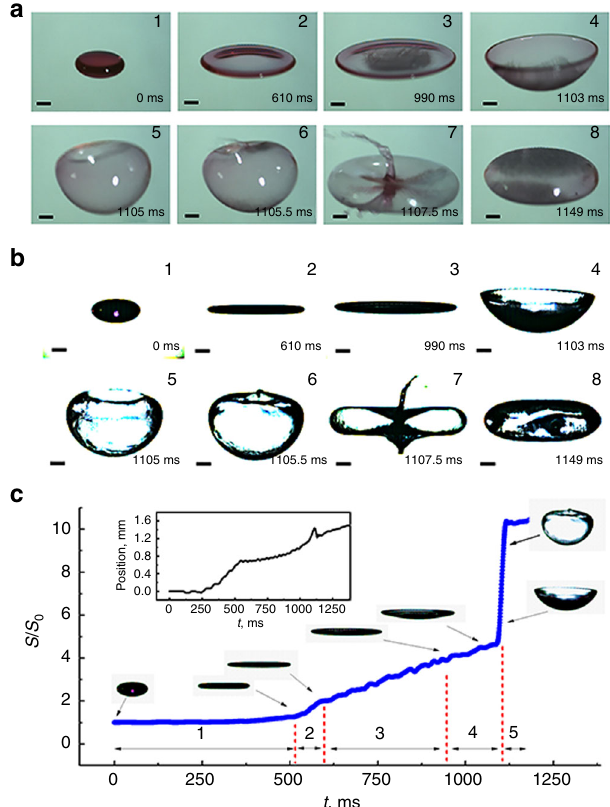
Fig. 1 Drop-to-bubble transition of acoustically levitated drop. The process was triggered via increasing sound intensity through decreasing the emitter – re fl ector distance at a rate u R = 1.50 mm/s. a Snapshots (taken with a high-speed camera titled at an angle of ~35°) of the evolution of a levitated oblate drop (0 ms) of aqueous sodium dodecyl sulfate (SDS) solution at its critical micelle concentration, CMC (~2.3 g/L). Upon increasing the sound intensity, the drop fl attens (610 ms) and buckles (990 ms). The buckled liquid fi lm then expands and its rim retracts inward (1103 – 1105.5ms), forming a closed bubble (1149 ms). Liquid jetting is shown in 1107.5 ms. To enhance visibility, the drop was dyed with a commercial red ink. The volume of the drop is 10 μ L. Each scale bar represents 1 mm. b Side-view snapshots of the same process as shown in a . c Surface area ( S ) variation of the drop with time divided into fi ve stages: (1) slight deformation, (2) rapid fl attening, (3) slow fl attening, (4) buckling, and (5) abrupt expansion with rim closure. Inset photos show side-view snapshots corresponding to each stage. Inset graphics shows the levitation position (the initial drop centroid was de fi ned as zero) of the drop/bubble was uplifted slightly (~1.5 mm) because of the lift of the nodal plane caused by the decrease of the emitter – re fl ector distance. The surface area is scaled to the initial surface area ( S 0 ) of a spherical